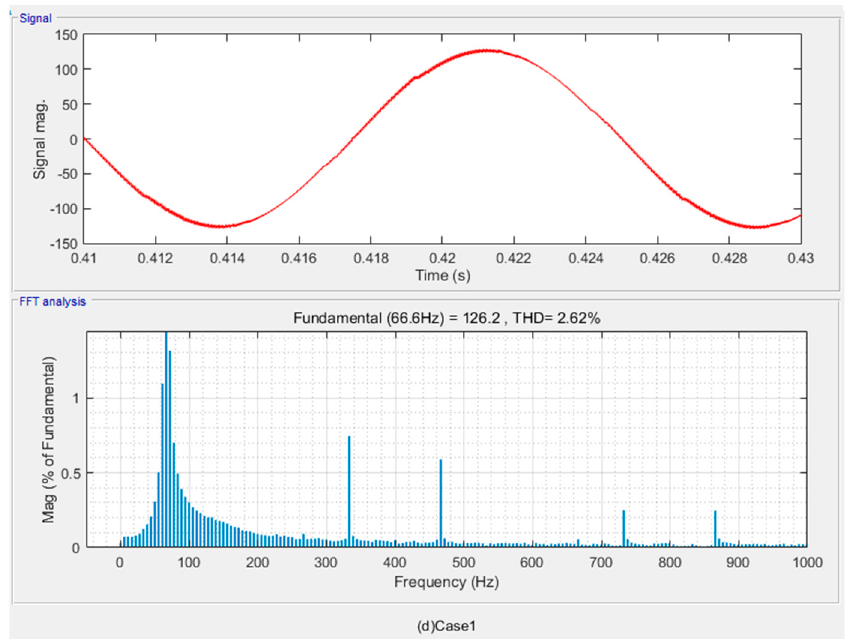
Figure 9. ( a – d ) The stator current waveforms and Fourier analysis results in four cases.